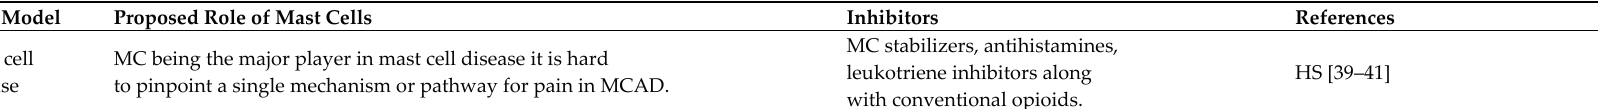
Table A1. Summary of disease-specific MC-mediated nociceptive